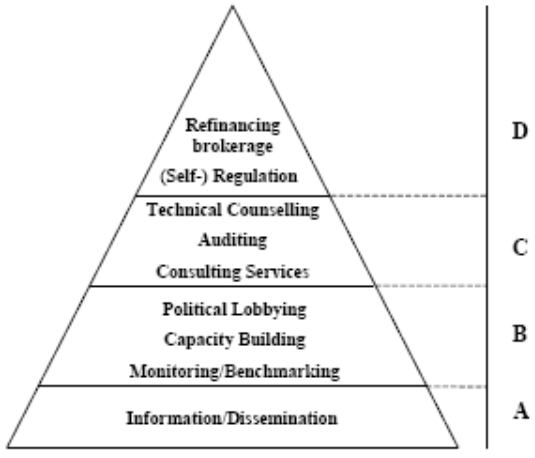
Service Pyramid of Microfinance